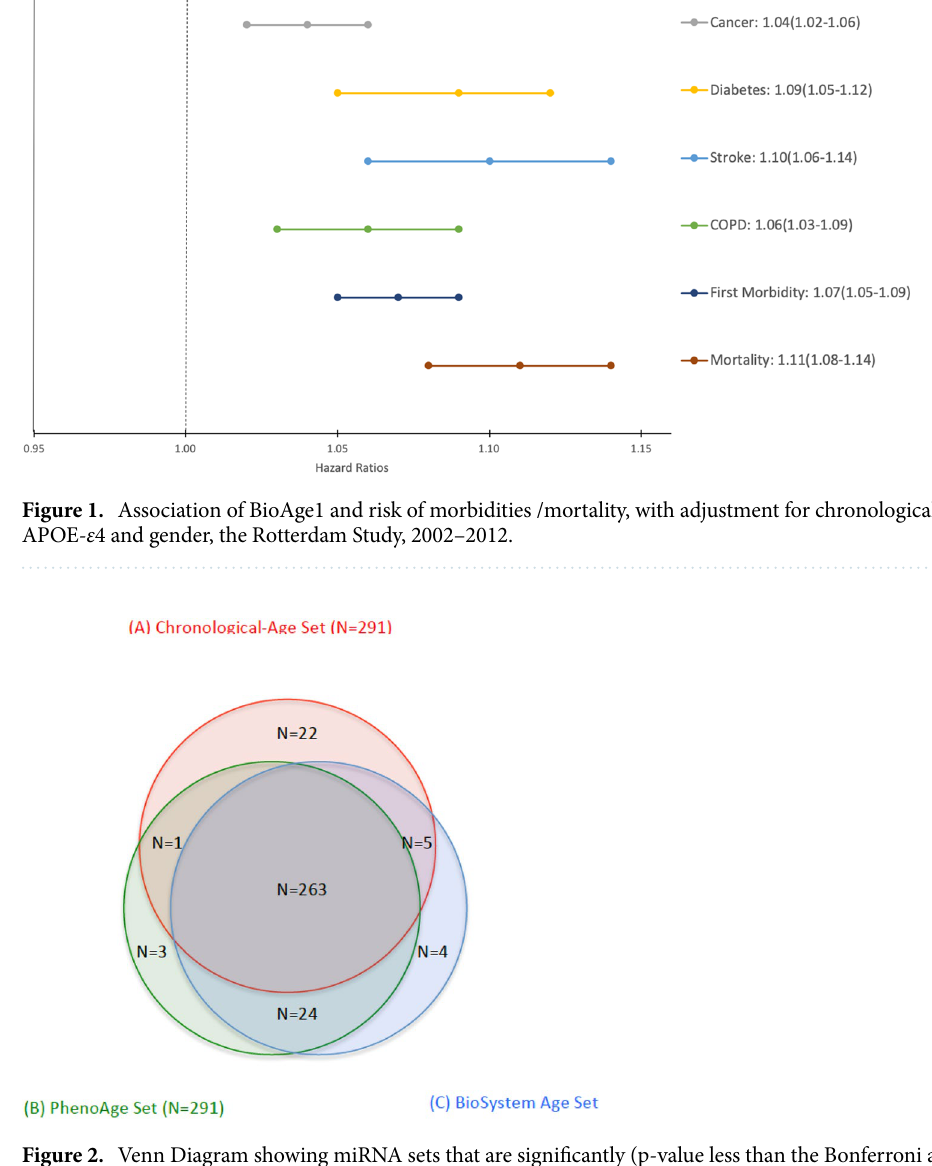
Figure 2. Venn Diagram showing miRNA sets that are significantly (p-value less than the Bonferroni adjusted cut-off of 0.000085) associated with ( A ) Chronological Age (n = 291, in red); ( B ) PhenoAge (n = 291, in green); ( C ) BioAge1 (n = 296, in